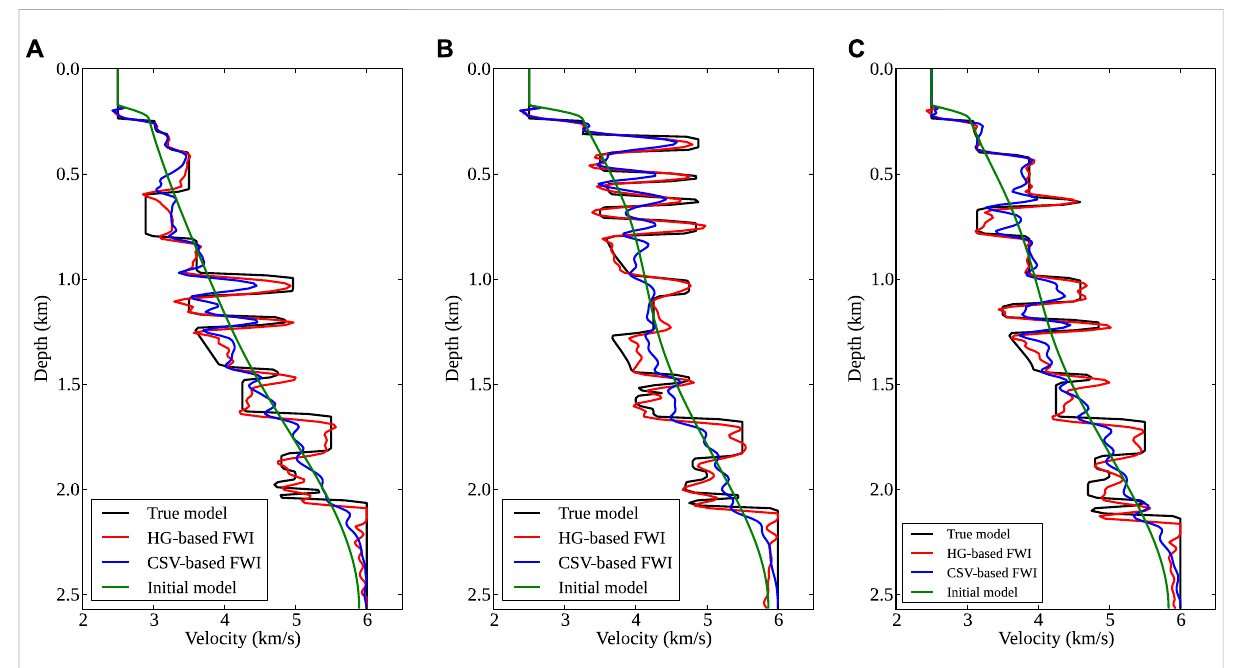
FIGURE 4 Comparisons of velocity logs for SEG/EAGE overthrust model. (A – C) are located at the midpoints of 1.25, 3.5, and 5.0 km, respectively. Black and green lines are from true and initial models, blue and red lines are from CSV-based FWI and HG-based FWI. HG-based FWI produces more accurate results than CSV-based method, especially at great depths with large-scale velocity anomalies.